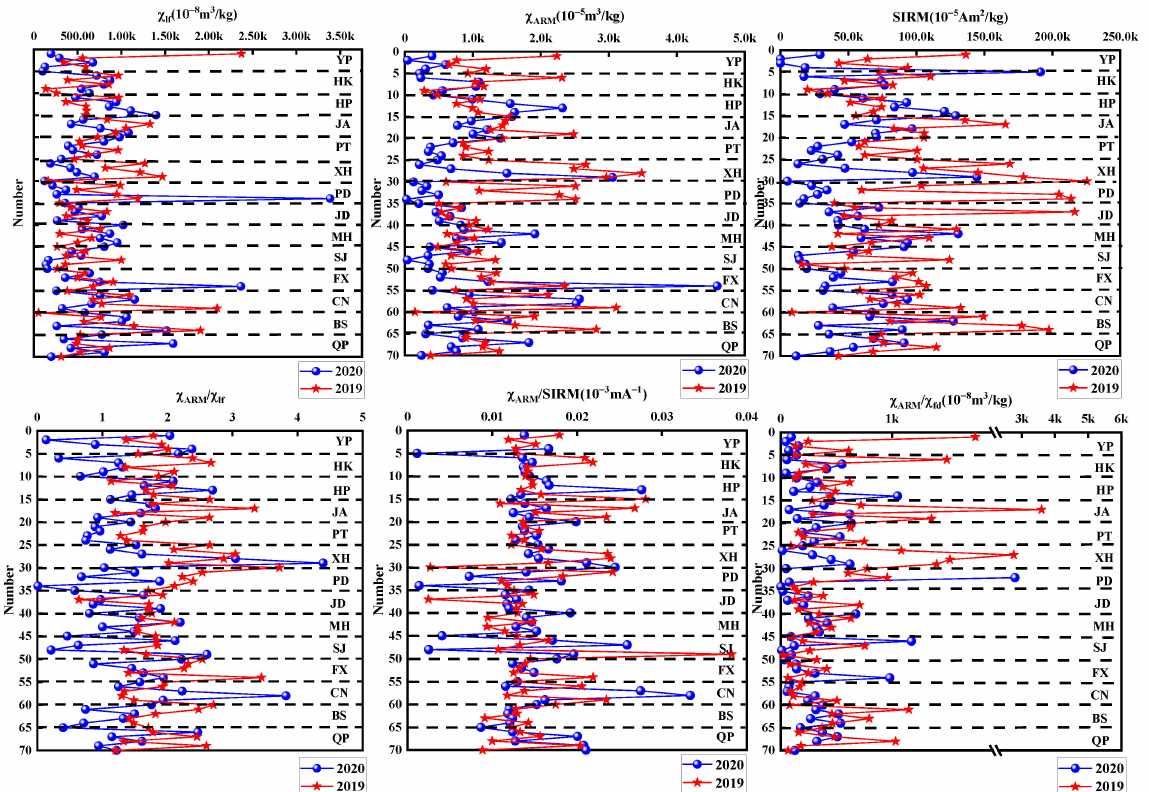
Figure 3. Temporal and spatial distribution characteristics of the magnetic